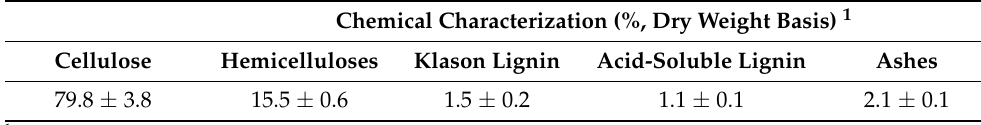
Table 1. Chemical characterization of the unbleached kraft pulp from Eucalyptus globulus